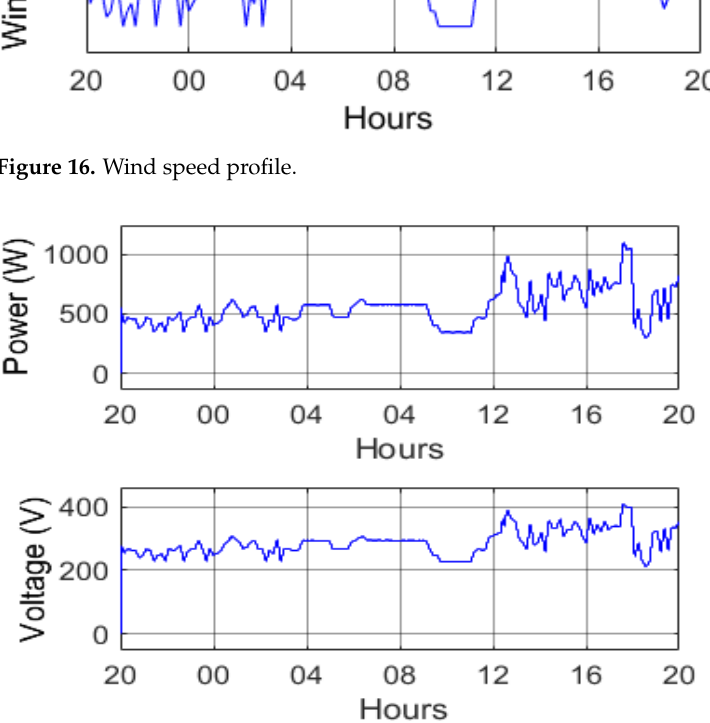
Figure 17. Power and the voltage of the wind turbine.